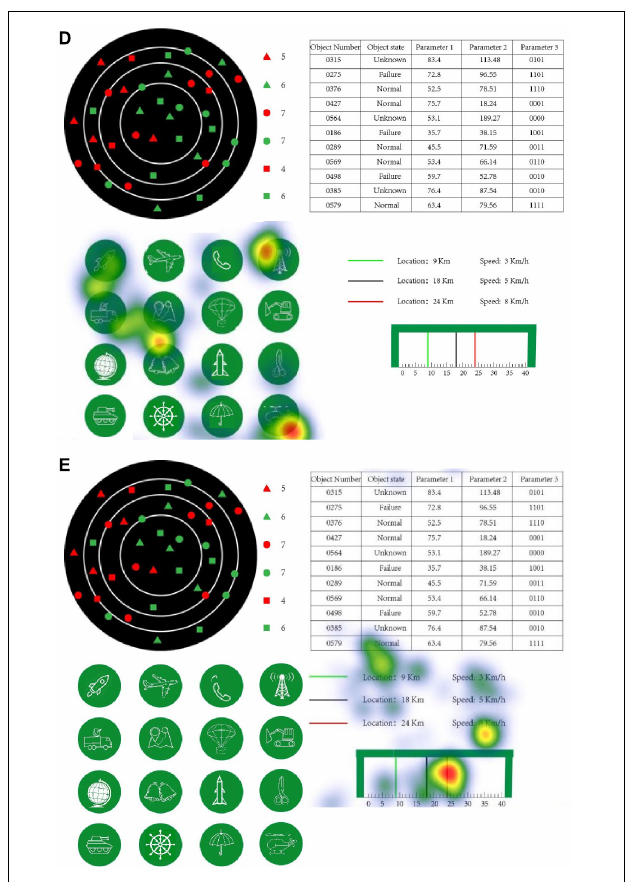
FIGURE 8 | Hot map of subjects in normal state. (A) Table query interaction task. (B) Monitoring and alert interaction task. (C) Target search interactive task. (D) Click interactive task. (E) Interactive task of state